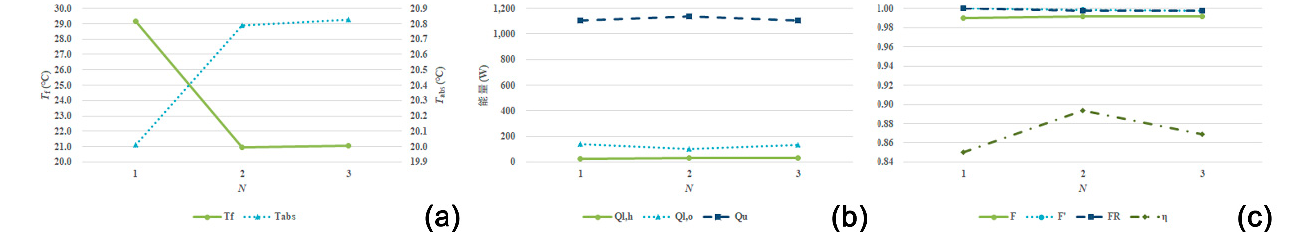
Figure 15. Influence of the number of layers ( N ) . ( a ) Dependence between T f , T abs , and N . ( b ) Dependence between energy, and N . ( c ) Dependence between efficiency parameters, and N .